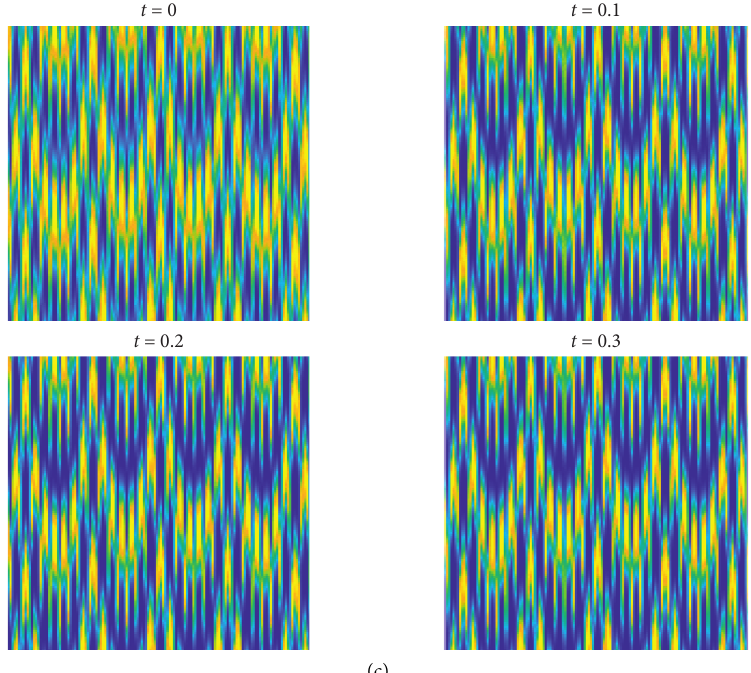
Figure 5: Numerical solution and pattern of Experiment 1 with initial condition η ( x,y, 0 ) � − sin ( x 2 + ( y /10 ))